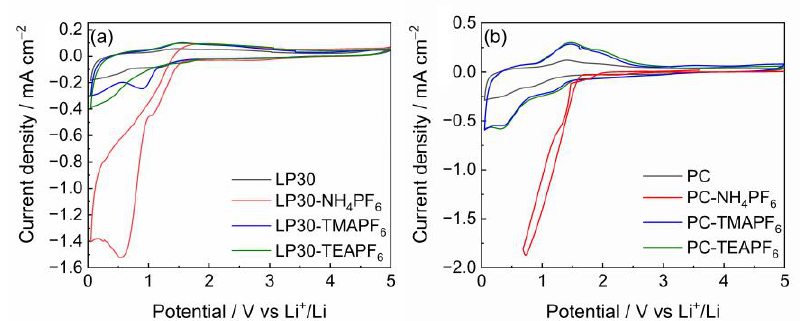
Figure 1. CVs at 20 mV s − 1 of ( a ) LP30 and ( b ) PC without and with the addition of 50 mM of NH 4 PF 6 , TMAPF 6 , and TEAPF 6 . NH 4 PF 6 , TMAPF 6 , and TEAPF 6